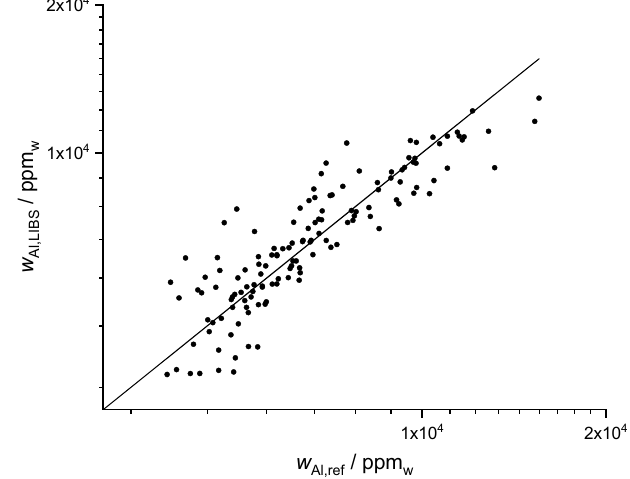
Figure 6. Results of 10-fold GPR cross validation for Al with R 2 (Al, GPR) = 0.81.